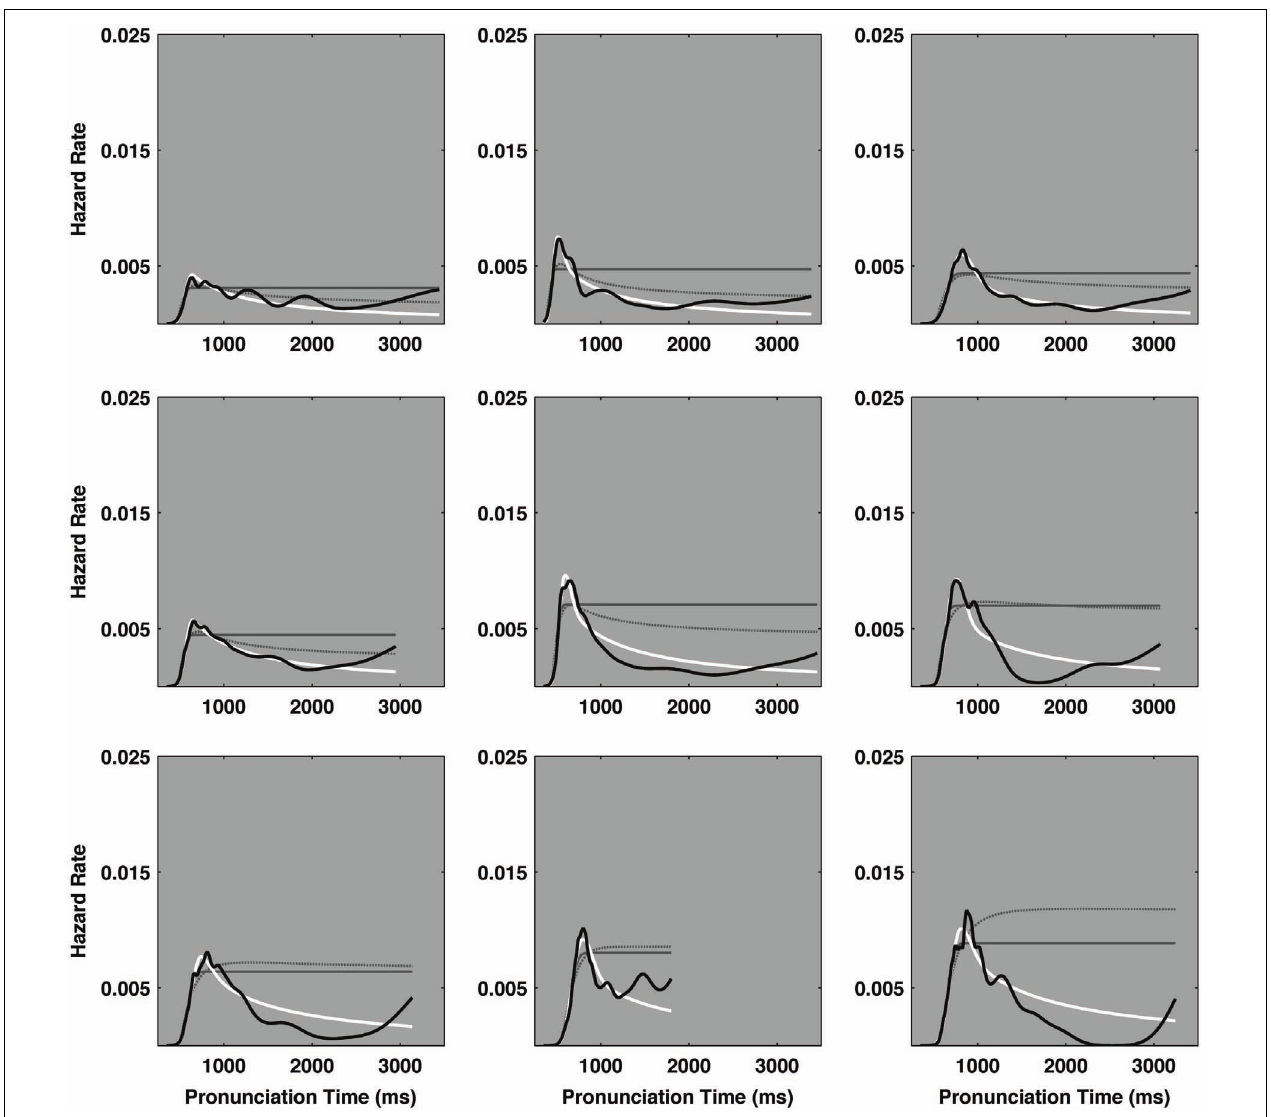
were effectively identical.The majority of the hazard functions entail a peak and their slow tails more closely match the power law decay indicated in the cocktail description than the exponential decay indicated by either the ex-Gaussian or ex-Wald models.The plots are depicted according to the ascending rank order of the scaling exponent derived from the cocktail fits. That is, the distribution in the top left plot yielded the smallest power law scaling exponent ( α = 3.74), the bottom right plot yielded the largest scaling exponent ( α = 8.01). α = power law scaling